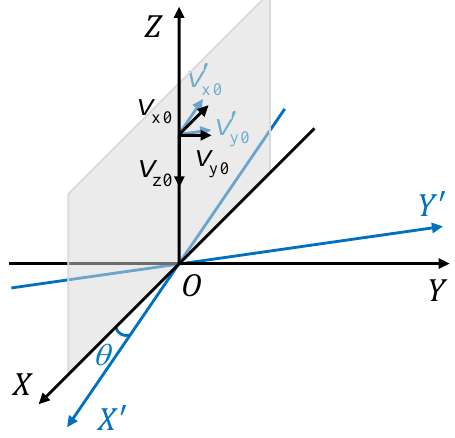
Figure 11. Rotation of the positive direction of the X-axis.